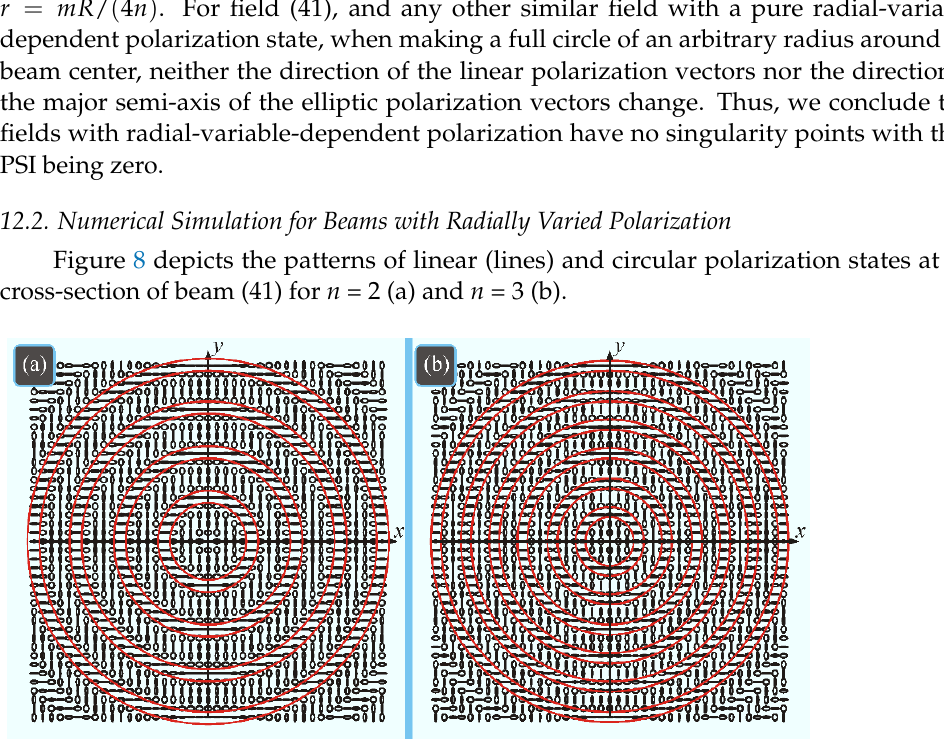
Figure 8. Jones vectors for field (41) with radially varied inhomogeneous polarization at ( a ) n = 2 and ( b ) n = 3. Regions with horizontal linear polarization are within circles.